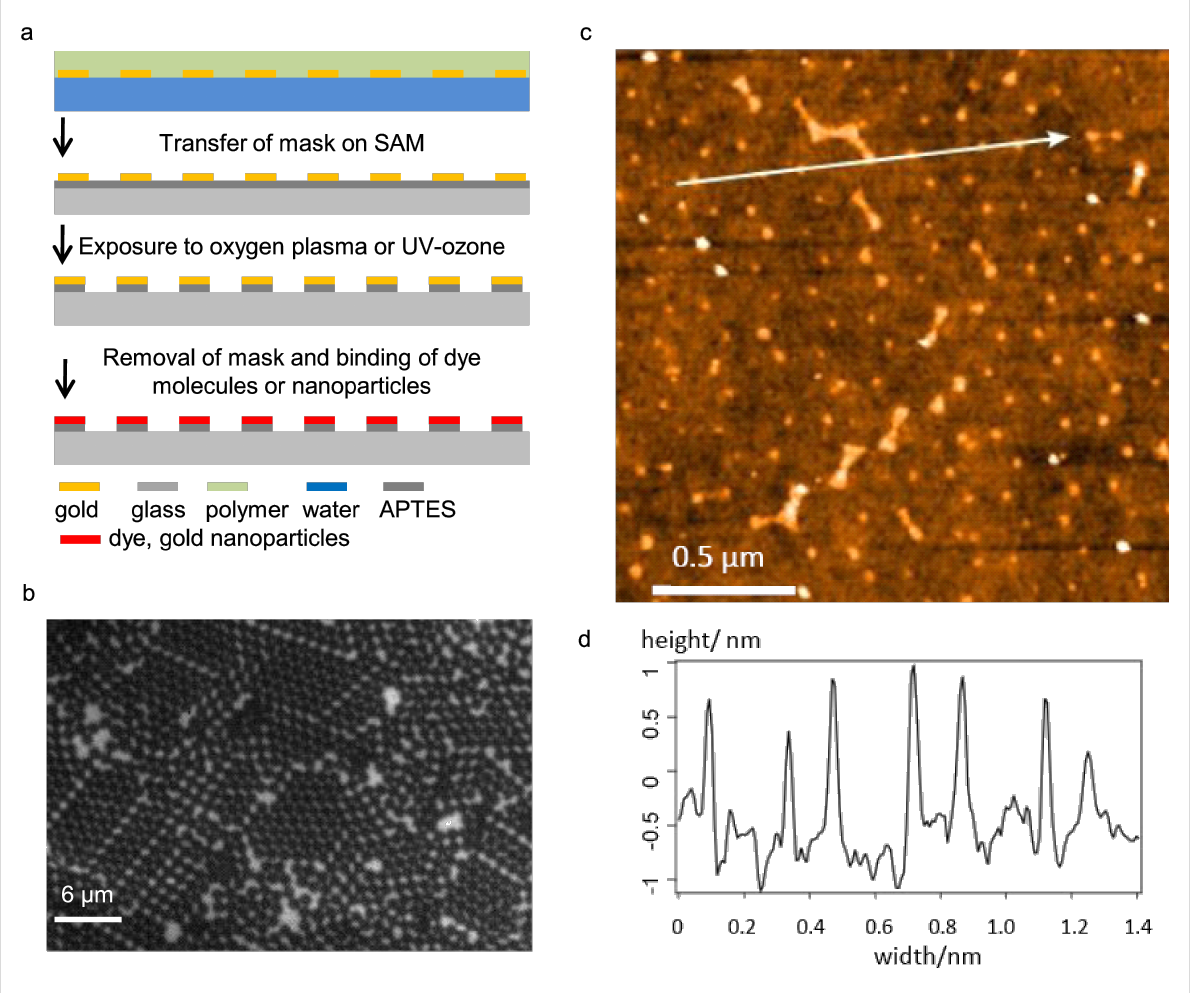
Figure 3: Oxygen-plasma induced chemical nanostructuring (process 2). (a) Schematic representation of the major preparation steps to form a chem- ically functionalized nanopattern. (b) Fluorescence micrograph of an APTES SAM nanopattern obtained by process 2 using mask 2 produced from a projection pattern of 1.2 µm latex beads after covalent binding of fluorescein molecules to the amino groups of the APTES. (c) Topography recorded by an atomic force microscope of an APTES SAM nanopattern obtained by the same procedure using a mask produced from a projection pattern of 0.22 µm latex beads after binding of negatively charged 1.4 nm gold nanoparticles to the positively charged amino groups of APTES. (d) Profile along the line indicated in